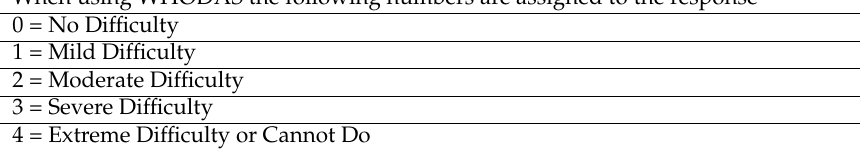
Figure 6. WHODAS scales.